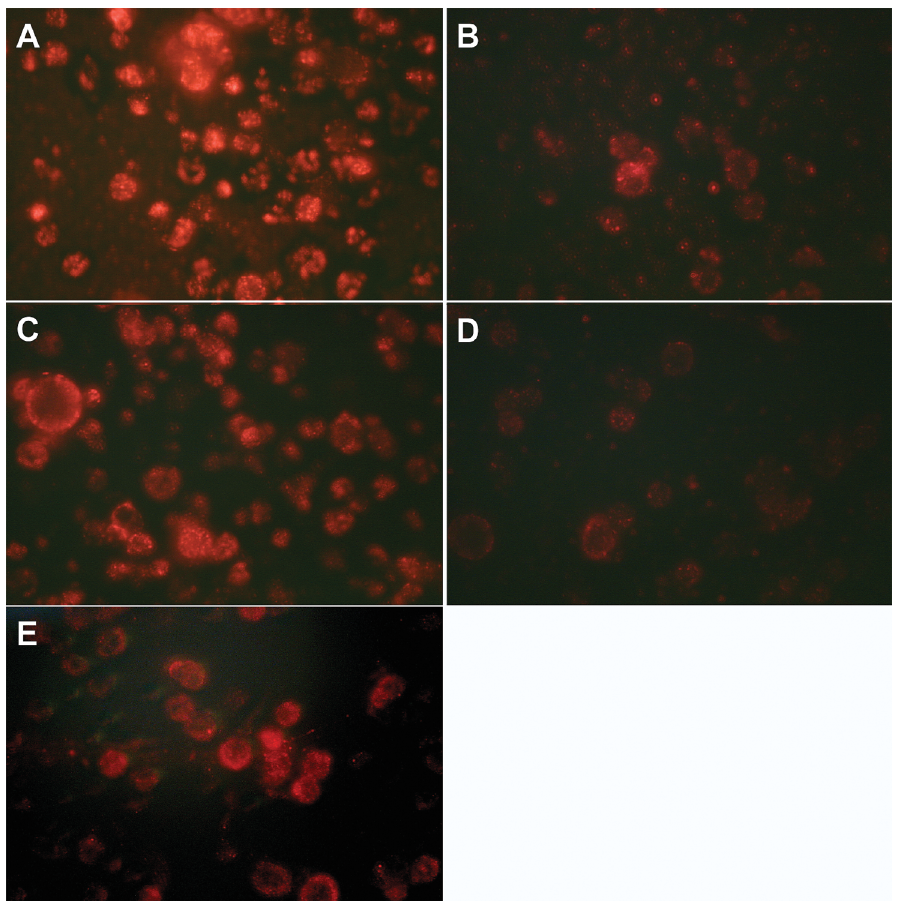
Figure 6. Uptake of rhoda- mine-labeled M. smithii ar- chaeosomes by murine peritoneal macrophages, and competition for uptake by un- labeled archaeosomes or lipo- somes. Competing unlabeled liposomes or archaeosomes (mean diameter = 100 nm) were added immediately prior to addition of rhodamine- labeled M. smithii archae- osomes. Uptake was allowed to occur for 30 min following addition of 25 µg of rhoda- mine-labeled M. smithii ar- chaeosomes to 1 ml of RPMI with 0.5 million adhered macrophages. The reaction was stopped by fixing macro- phages in 1% formaldehyde, and photographs were taken using an inverted microscope. (A) no competitor; (B) 50 µg unlabeled M. smithii archae- osomes; (C) 50 µg unlabeled H. halobium archaeosomes; (D) 50 µg unlabeled PS/PG liposomes; and (E) 250 µg un- labeled PI